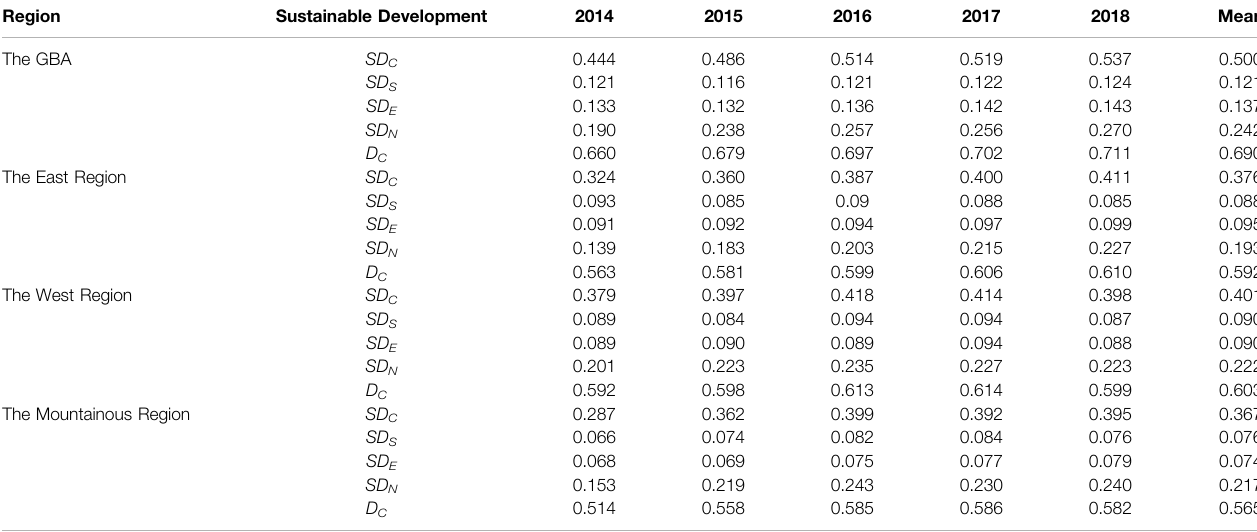
TABLE 5 | Sustainable development of the compound ecosystem in the GBA and three surrounding regions.